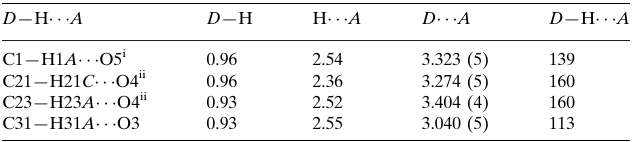
Hydrogen-bond geometry (A˚ , (cid:3)